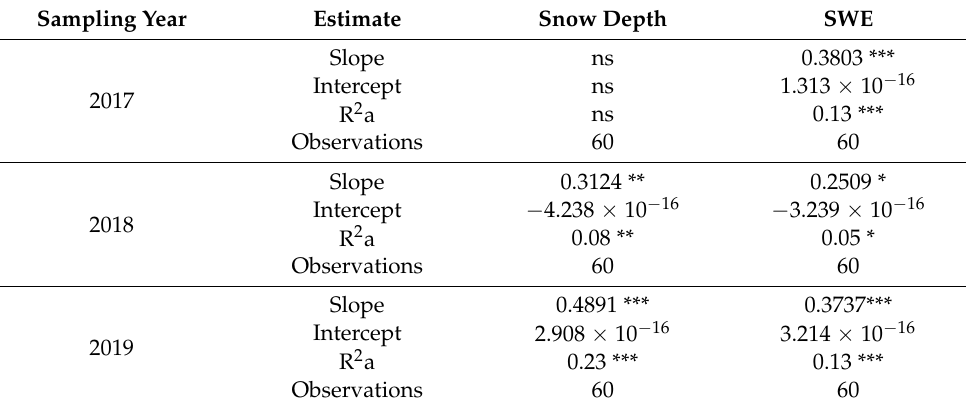
Figure 7. Relationship of the d-excess and snow depth, SWE over the sampling years and basin parts (NP, CP, SP). Table 5. Adjusted R 2 , slopes and intercepts for computed regression equations describing d-excess vs. snow depth and SWE relationships (ns = predictor variable not selected).